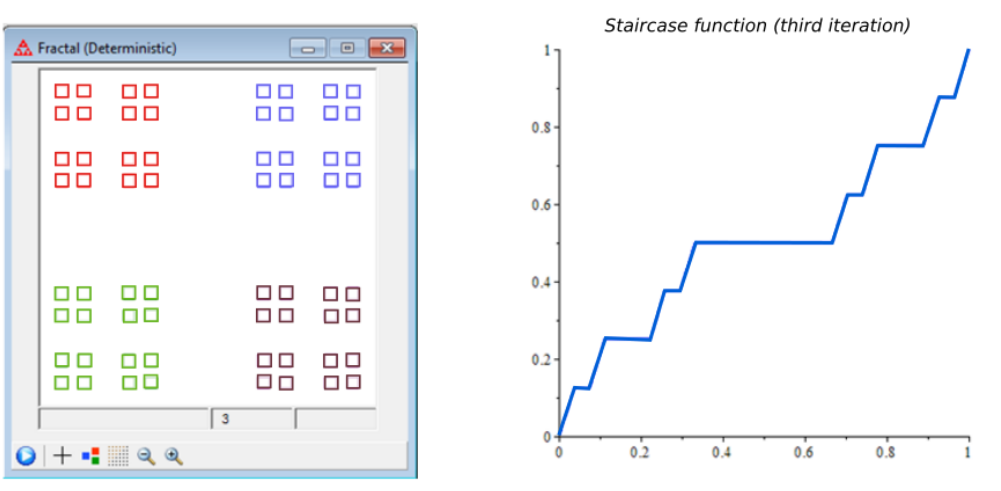
Figure 3. Staircase function for the second iteration.